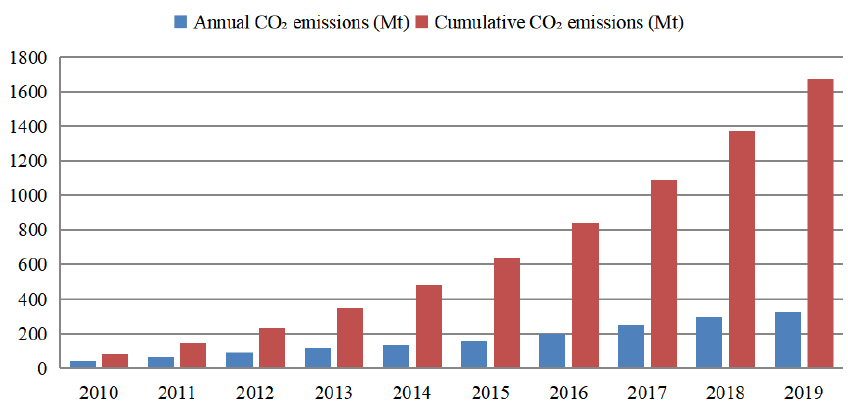
Figure 11. CO 2 emission reduction benefits of China’s wind power in 2010– 2019.